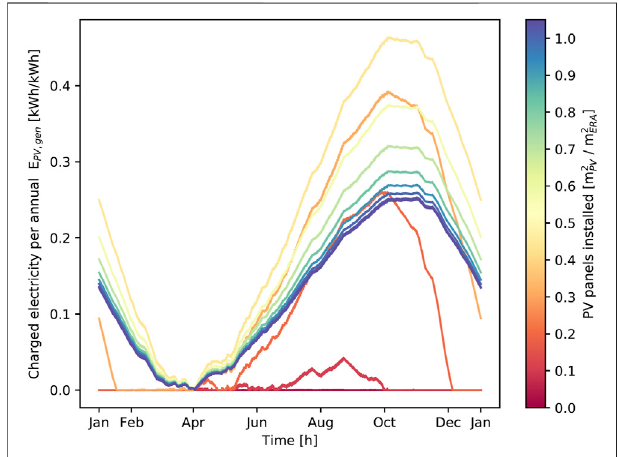
FIGURE 11 | State of charge of a storage system aiming at self- suf fi ciency (SS) for different levels of PV